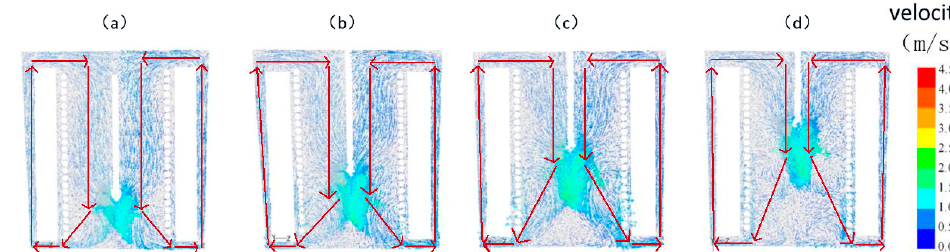
Figure 3. Diagram of velocity distribution of the coil heat exchanger with different agitator heights. ( a ) h = 40 mm; ( b ) h = 60 mm; ( c ) h = 80 mm; ( d ) h = 100 mm.